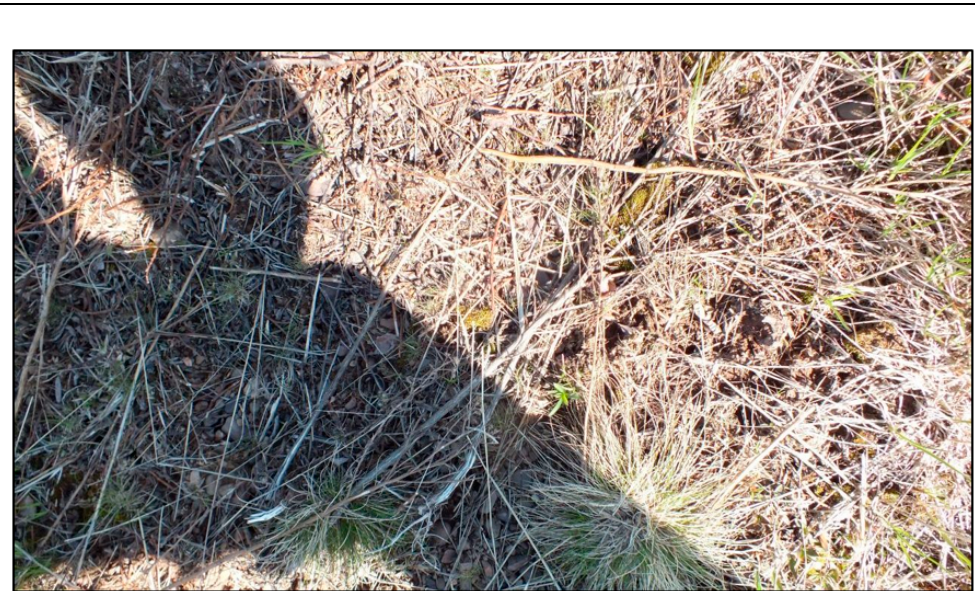
Table 6. Classification results for images with or without sheep sorrel.